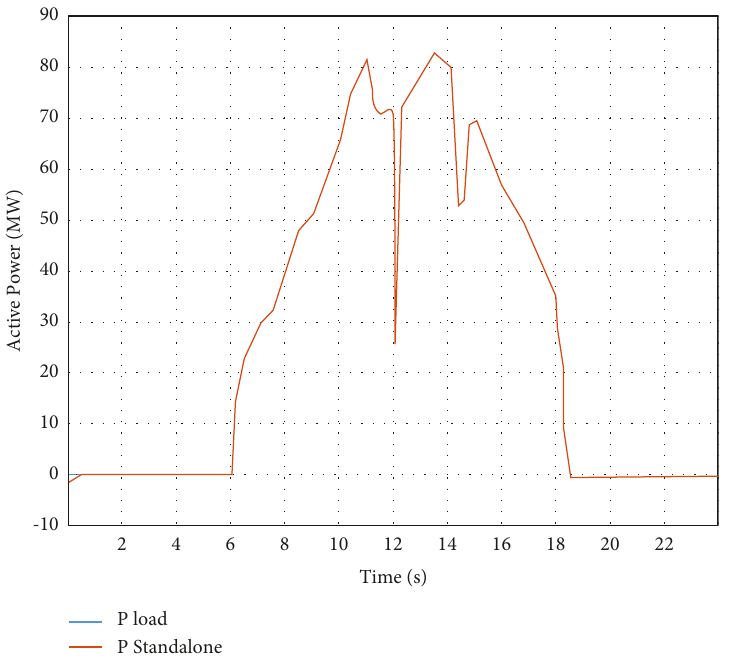
Figure 21: Performance of the wind farm power during load and wind speed step